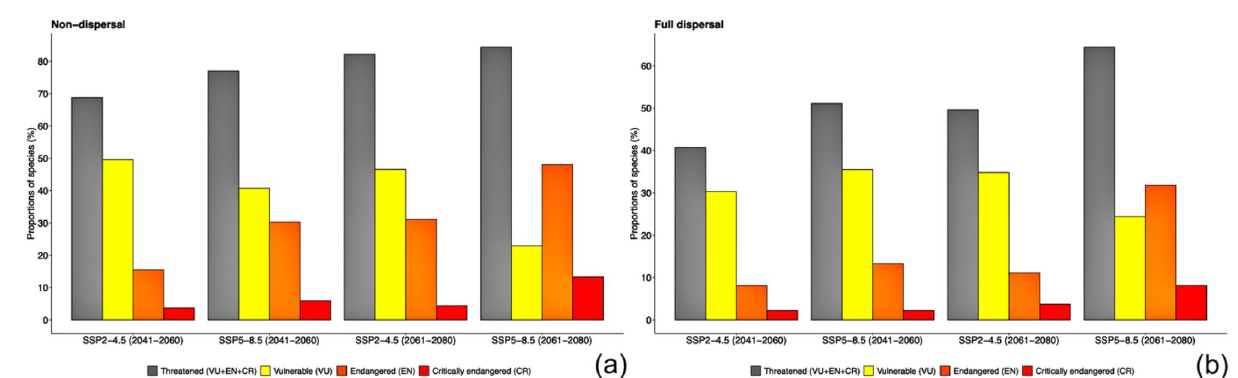
Figure 3. Percentage of Brazilian agroforestry plant species potentially qualified in a threat categories VU + EN + CR, and in separate categories Vulnerable (VU), Endangered (EN) and Critically Endangered (CR), under two different climate change scenarios (SSP2-4.5 and SSP5-8.5) for the following time periods: 2041–2060 and 2061–2080, assuming two dispersal scenarios: ( a ) non-dispersal and ( b ) full